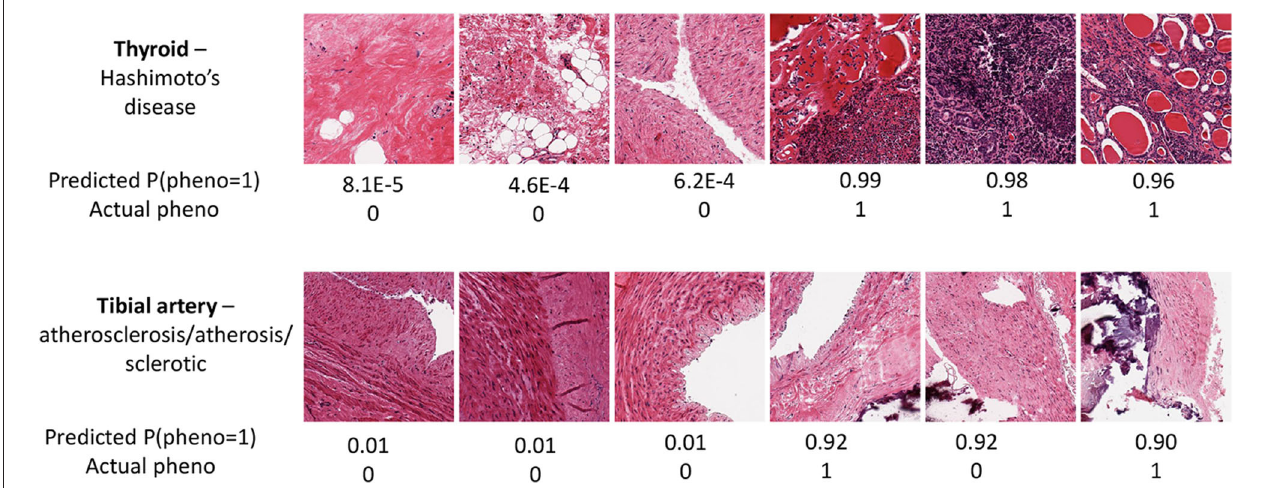
FIGURE 4 | Image samples for two tissues and associated pathologies, for the samples with the three highest and lowest predicted probabilities for thyroid Hashimoto’s disease (Top) and tibial artery atherosclerosis (Bottom) .